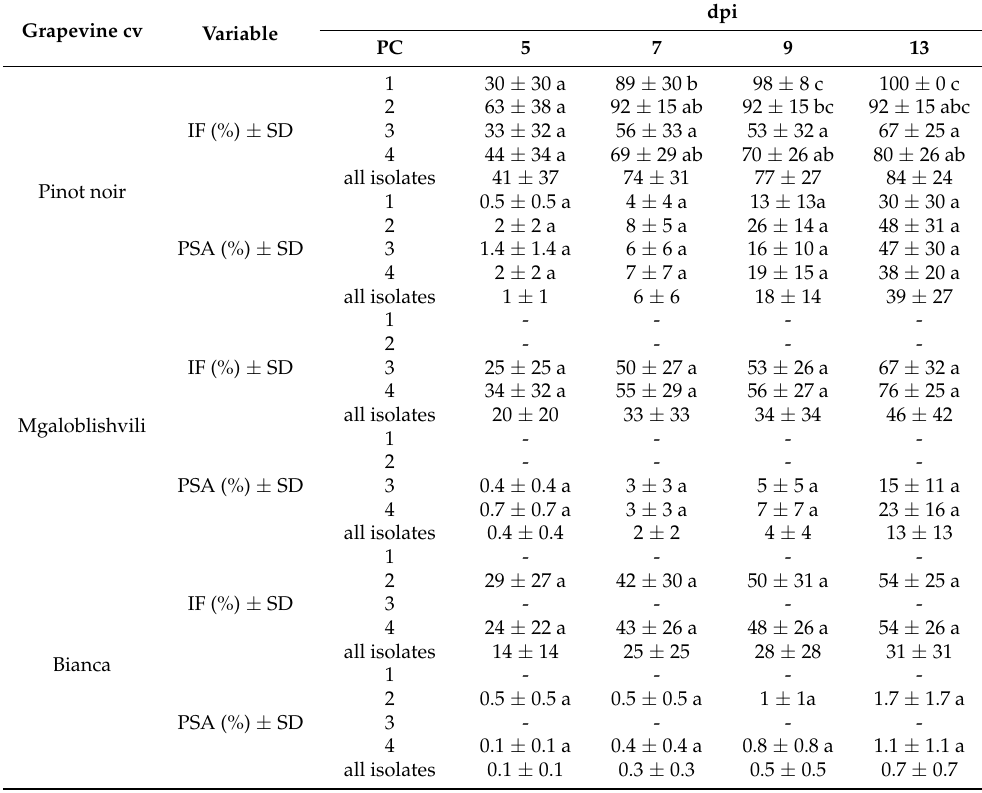
Table 1. Percentage of infection frequency (IF) and percentage of sporulating area (PSA) ± standard deviation (SD) recorded by P. viticola strains grouped or not into pathogenicity classes (PC) on Pinot noir, Mgaloblishvili, and Bianca. Different letters within columns indicate the existence of significant differences among the IF and PSA values of the different PC classes ( p < 0.05).